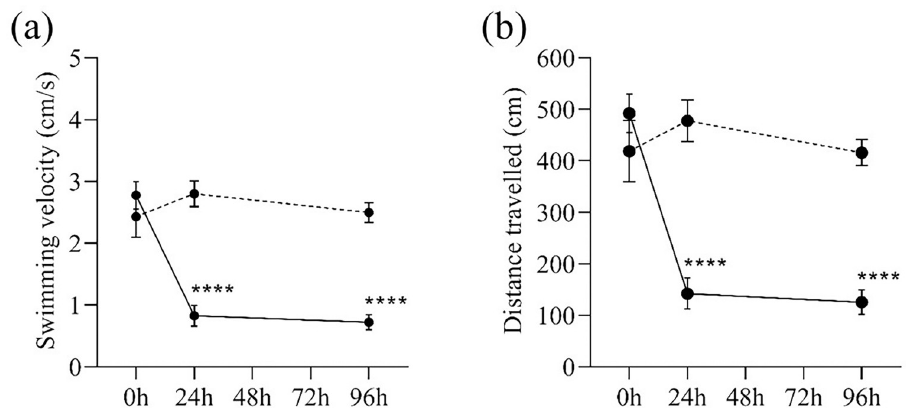
Fig 3. General locomotor activity of MPTP-injected (solid lines) and control (dashed lines) zebrafish. (a) Swimming velocity (in cm/s) and (b) Distance travelled (in cm) during the three-minute behaviour test at different time-points after the injection. Two-way RM ANOVA revealed that there were statistically significant interactions between the effects of MPTP injection and time on zebrafish swimming velocity (F (2,76) = 18.47, p < 0.0001) and distance travelled (F (2,76) = 18.16, p < 0.0001). Post-hoc Tukey’s test found that the mean swimming velocity and distance travelled of MPTP-injected group were significantly different between 0h and 24h (velocity: p < 0.0001, 95% CI = [1.24, 2.67]; distance travelled: p < 0.0001, 95% CI = [241.10, 458.80]), and between 0h and 96h (velocity: p < 0.0001, 95% CI = [1.34, 2.77]; distance travelled: p < 0.0001, 95% CI = [265.80, 466.80]). All values are presented as mean and error bars represent the SEM. n = 20 per group. ���� p < 0.0001.